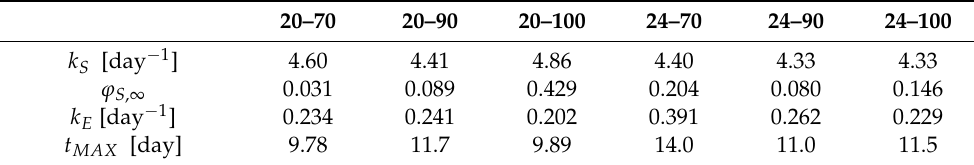
Table 3. Best fit results of BSA release kinetics modelling for the six MP